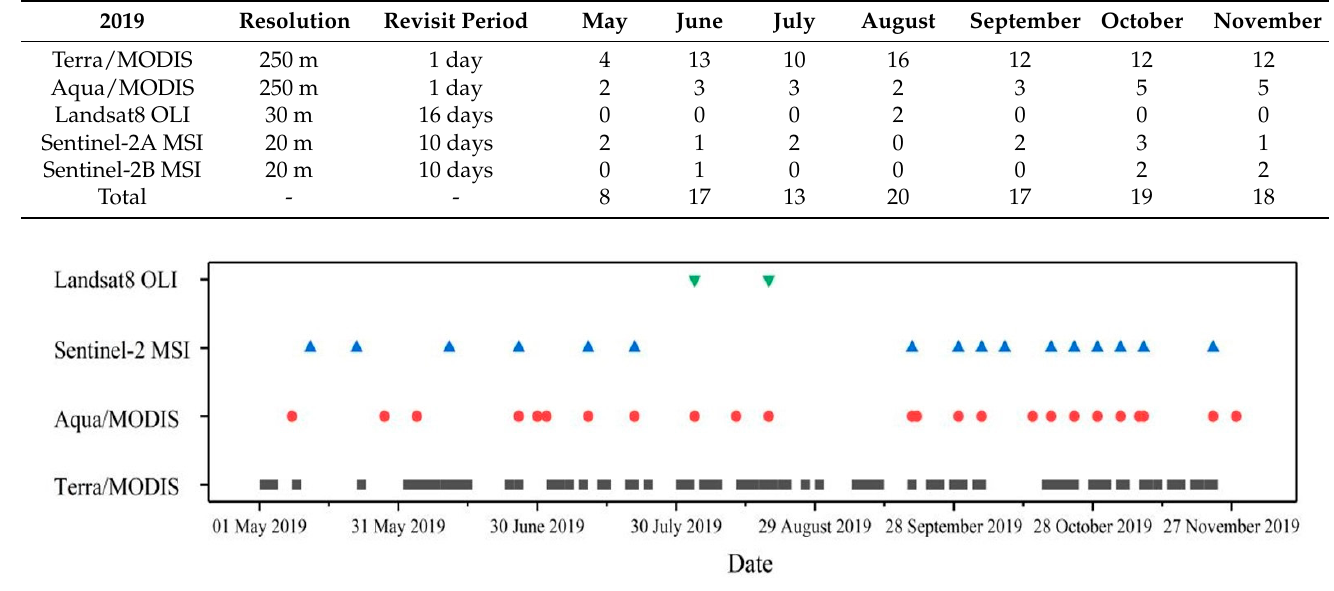
Figure 2. Annual distribution of cloudless images from multi-sensor data.